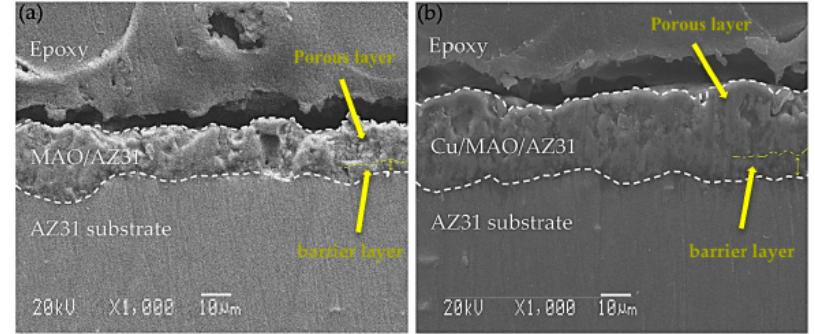
Figure 2. SEM cross-sectional images of ( a ) MAO/AZ31, ( b ) Cu/MAO/AZ31.